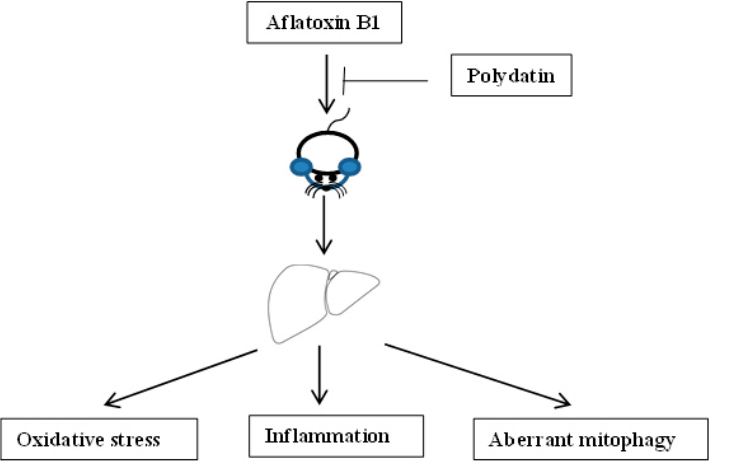
Figure 5. Schematic representation of the protective effect exerted by polydatin on hepatic injury induced by aflatoxin B1.